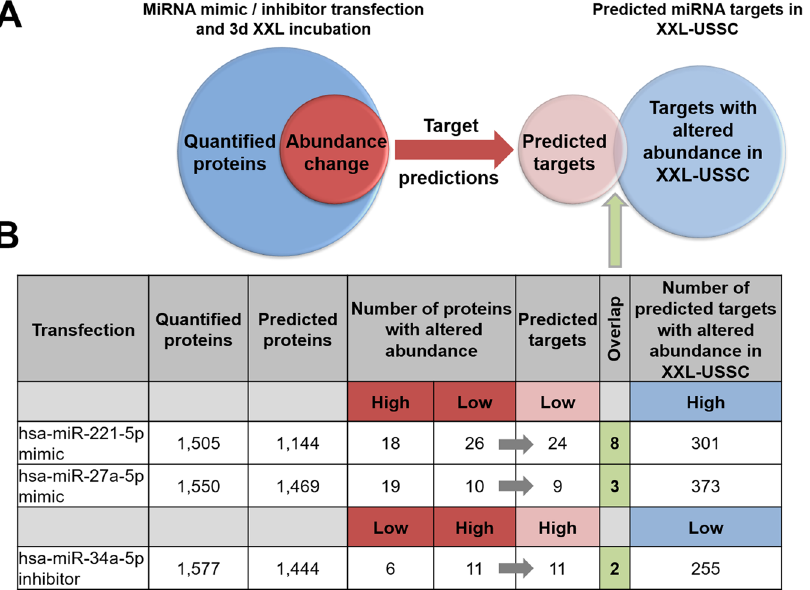
Figure 7. Summary of bioinformatic analysis of miRNA transfections and subsequent differential protein expression in XXL-USSC. ( A ) Bioinformatic workflow. Proteins regulated in 3d XXL-USSC upon transfection with mimics/inhibitors (left Venn diagram) were filtered for predicted targets (red arrow, using all 12 algorithms from miRWalk 2.0) and cross-analysed with inversely regulated predicted targets in non-transfected XXL-USSC (right Venn diagram). ( B ) For each miRNA mimic/inhibitor transfection, numbers of quantified proteins in transfected 3d XXL-USSC, predicted target proteins hereof, proteins with altered abundance (high and low) upon transfection, predicted targets hereof, and overlap (light green cell/column) with inversely regulated predicted targets (changes in abundance at 3d and/or 7d XXL incubation) in XXL-USSC are